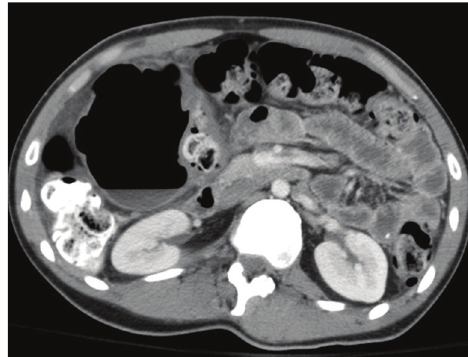
Figure 4: The lumen of the sigmoid colon sharing a common wall with the duplication cyst but without direct